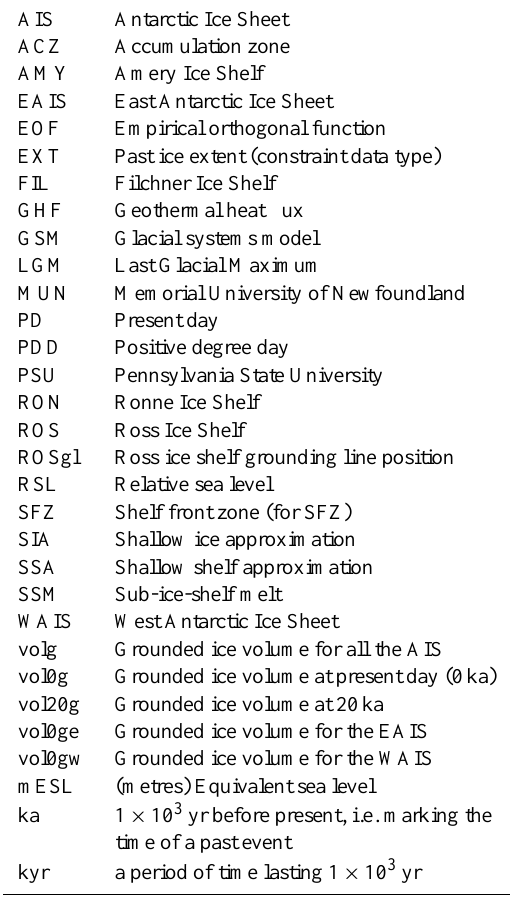
Table 1. Table of